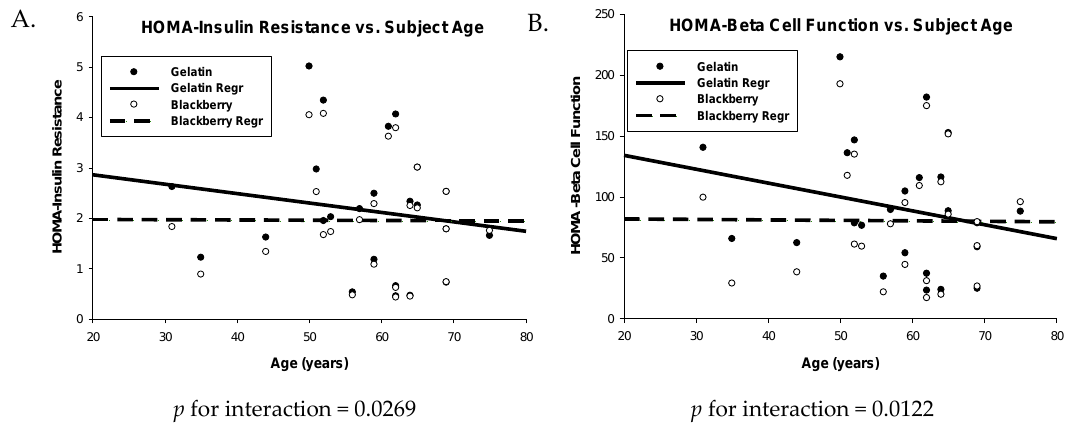
Figure 4. HOMA-IR ( A ) and HOMA- β ( B ) indices for adult men after consuming a diet containing blackberries vs. gelatin for seven days. Scatter plots are model predicted dependent variables vs. age separated by diet treatment. n = 24 subjects.